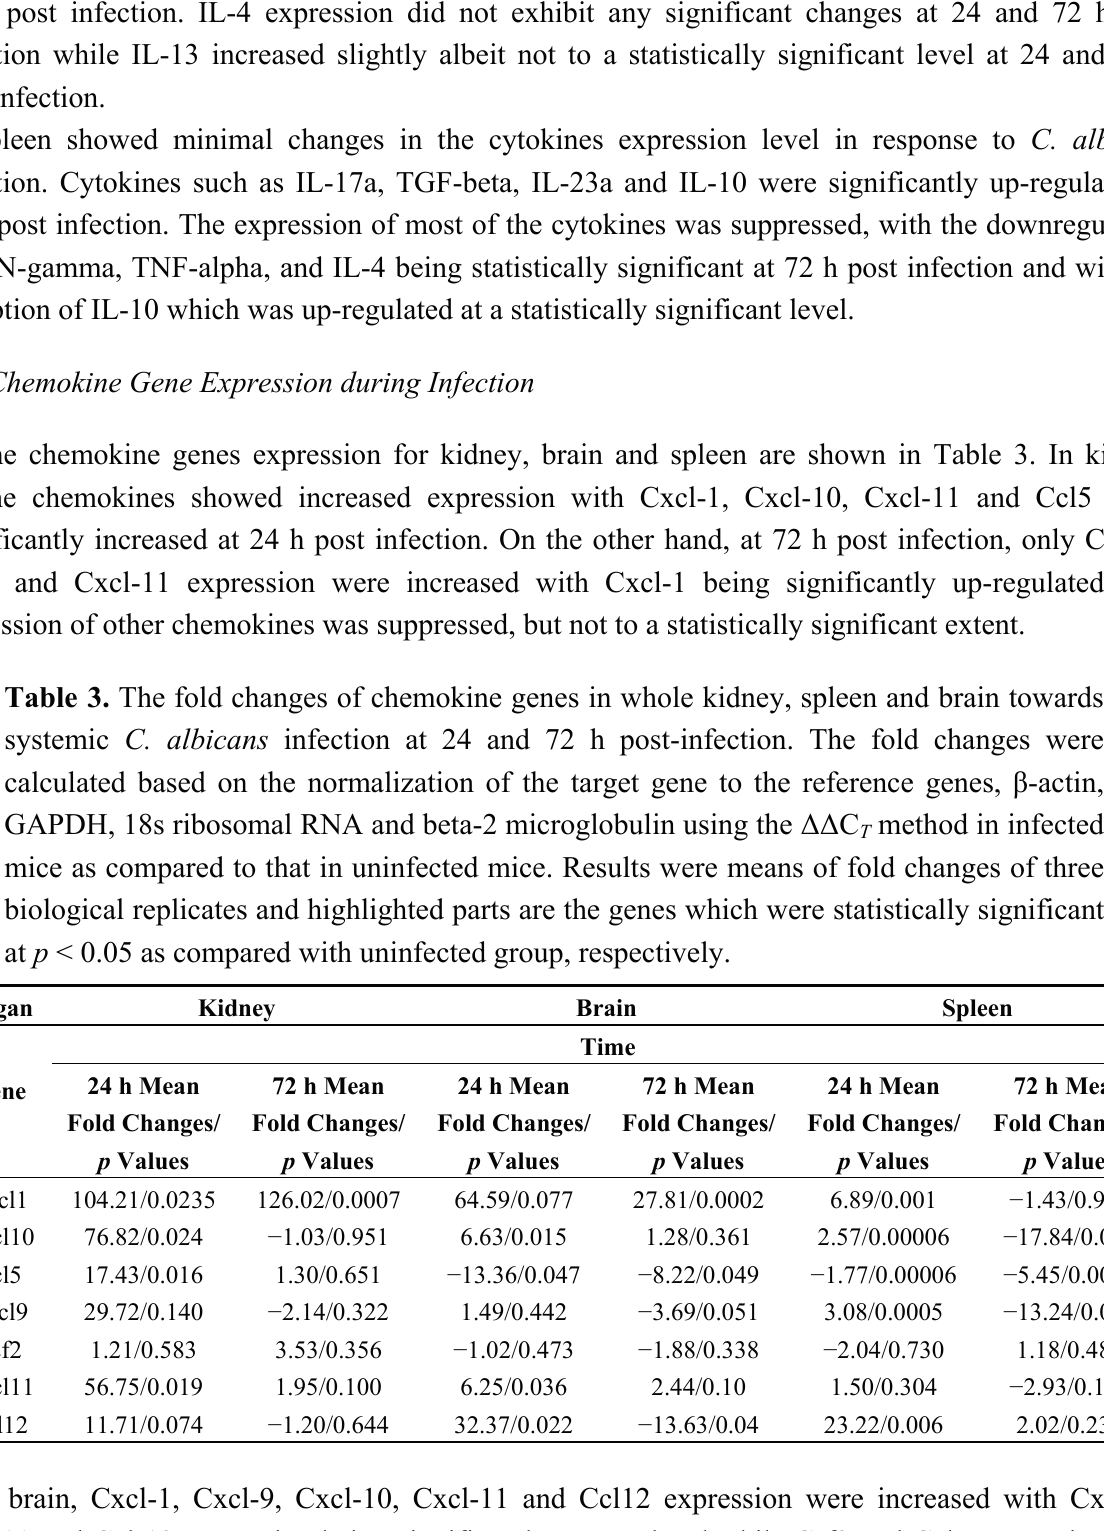
method in infected T